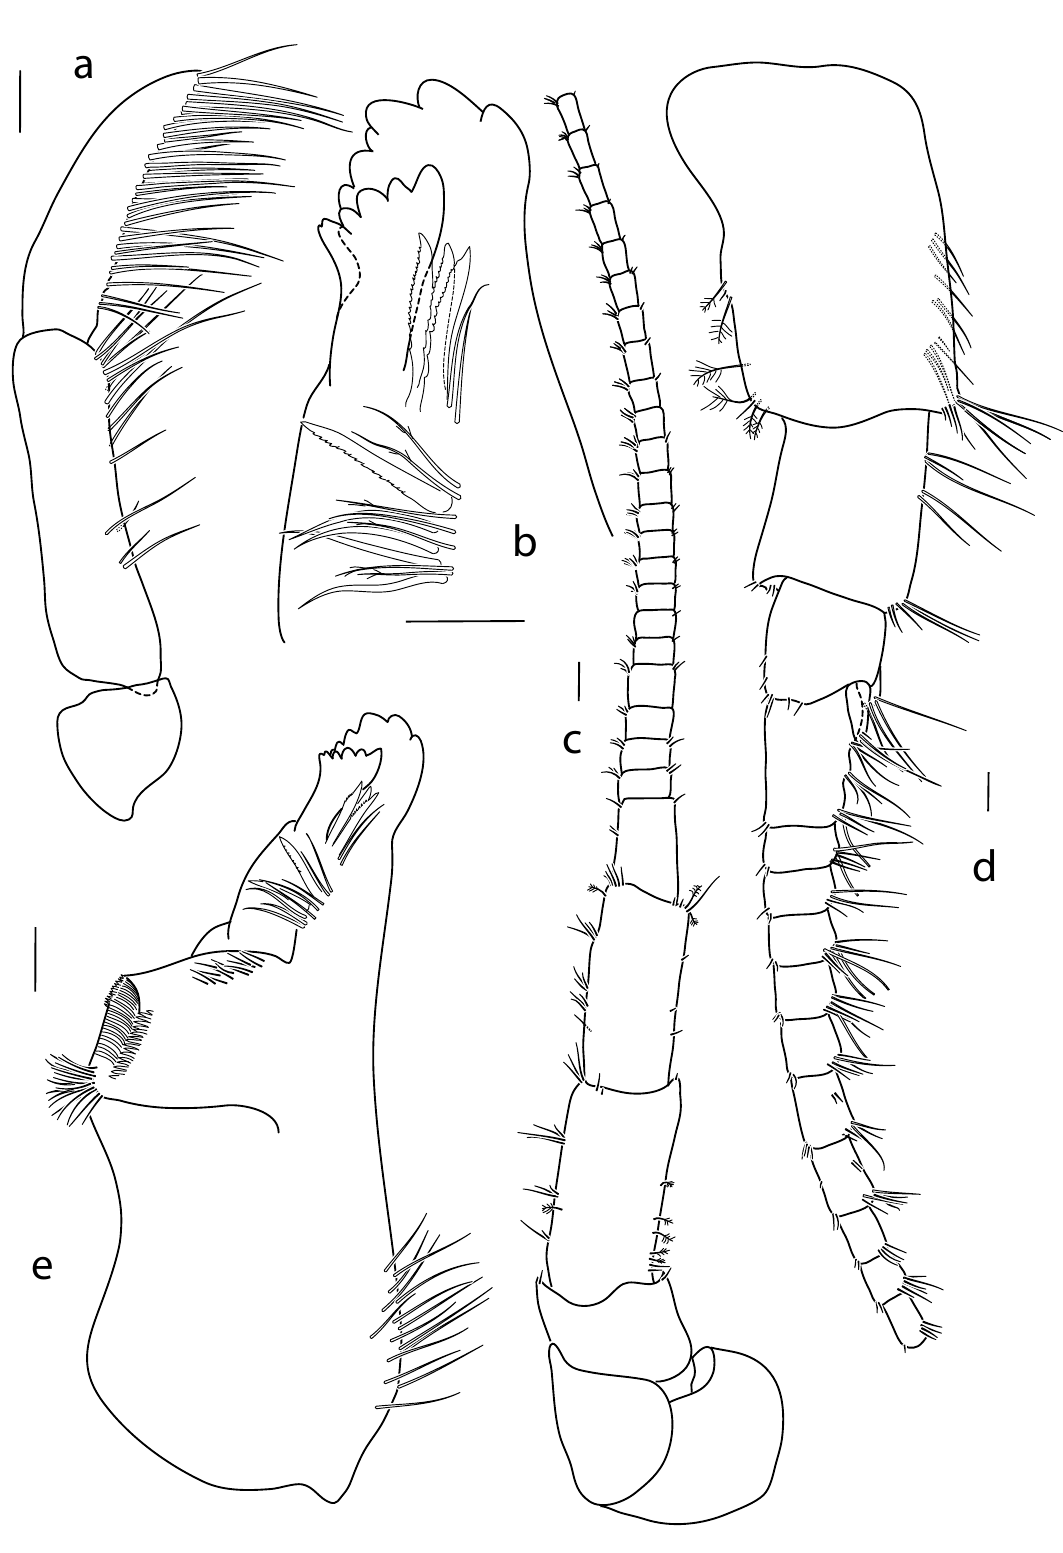
Fig. 13. Epimeria (Metepimeria) acanthurus (Schellenberg, 1931), ♀, 22 mm (ZMB 34099). a . Mandible palp. b . Mandibular incisor, lacinia mobilis and raker row. c . Antenna 2. d . Antenna 1. e . Mandible. Scale bars = 100